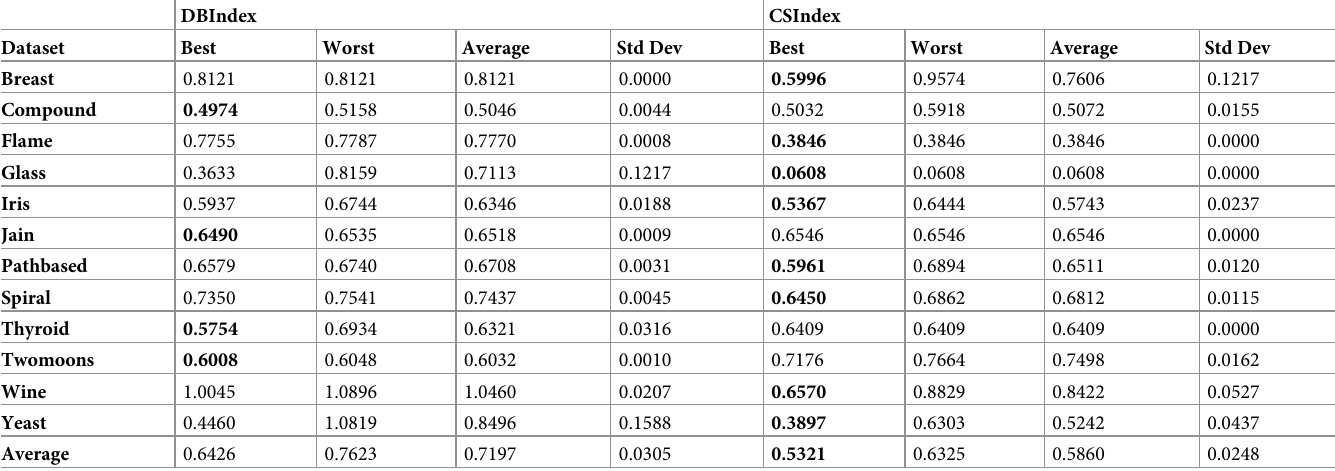
Table 5. SOSK-means results in over forty independent runs with DB and CS validity indices as the fitness function. DBIndex CSIndex Dataset